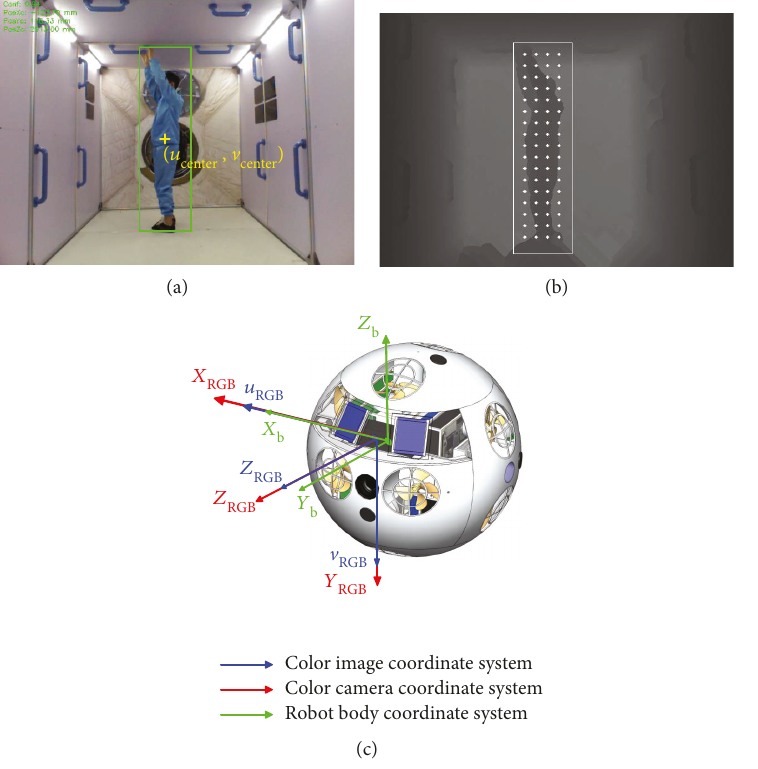
Figure 13: Images of RGB-D camera and coordinate system de fi